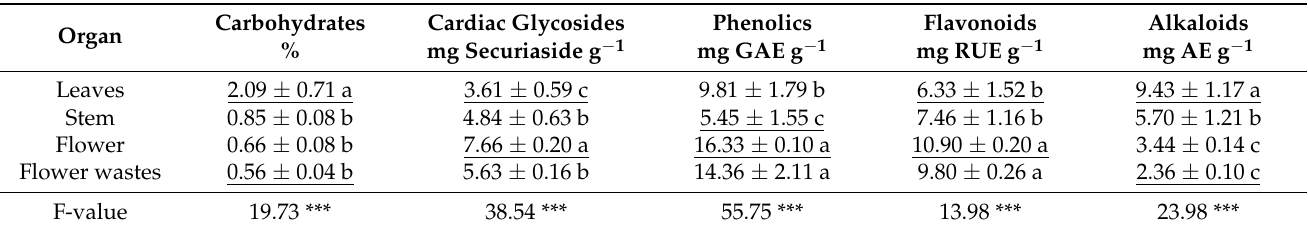
Table 1. Phytochemical constituents (mean ± SD, n = 12) of the different organs as well as the solid distillation wastes of Taif’s rose collected from Al-Shafa highlands in Taif City, Saudi Arabia. Maximum and minimum values are